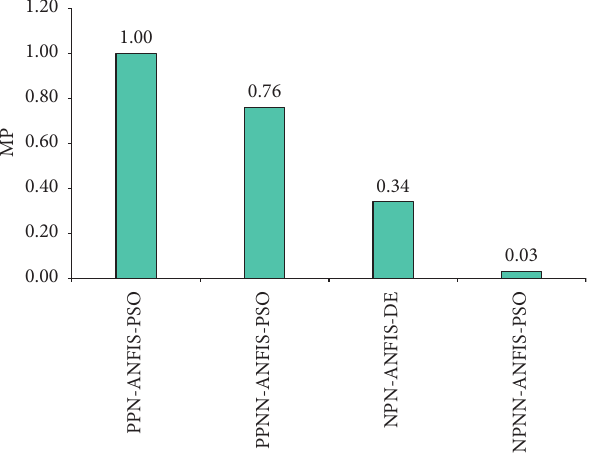
Figure 6: The best attained predictive models in accordance with the mean performance index over the testing phase.